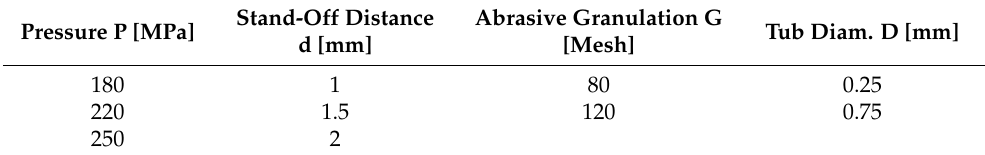
Table 2. Parameters proposed for optimization.